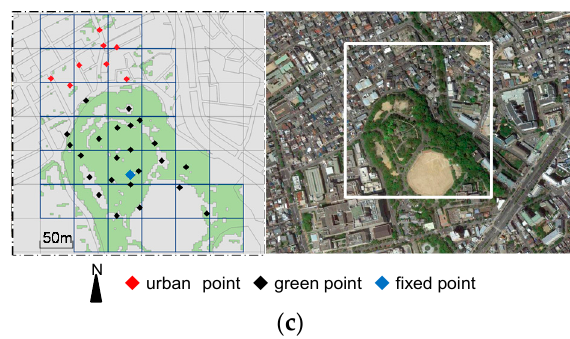
Figure 1. Mobile measurement points and aerial photograph, all located in Kobe city, Japan. ( a ) Higashi-yuen Park and business area; ( b ) Ishiyagawa Park and residential area; ( c ) Okurayama Park and residential area.